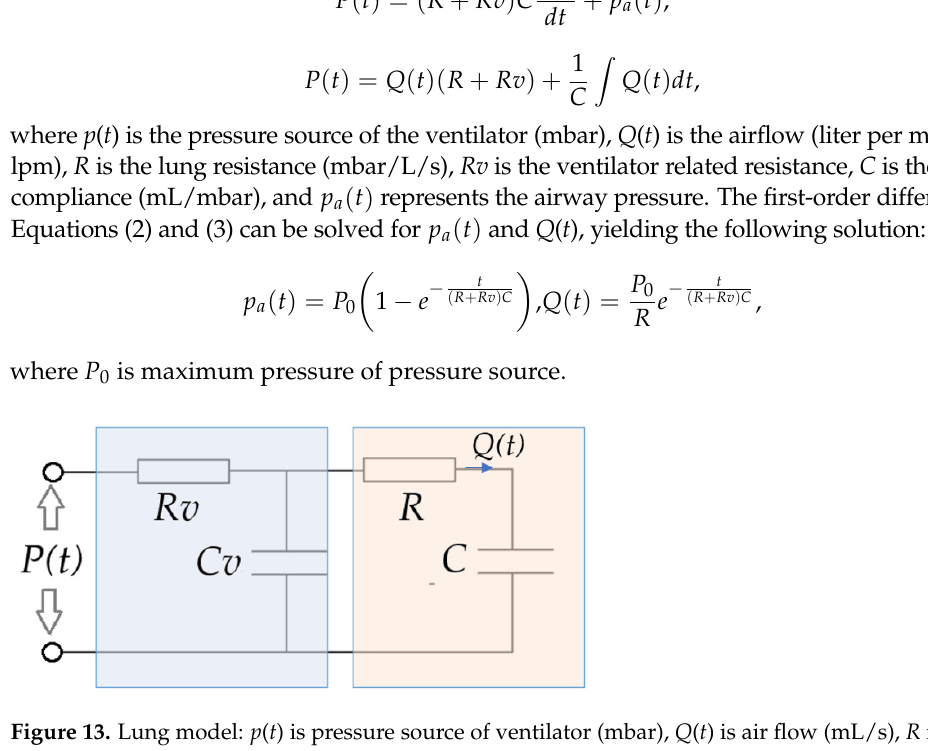
(𝑡) and Q ( t ), yielding the following (cid:3028)